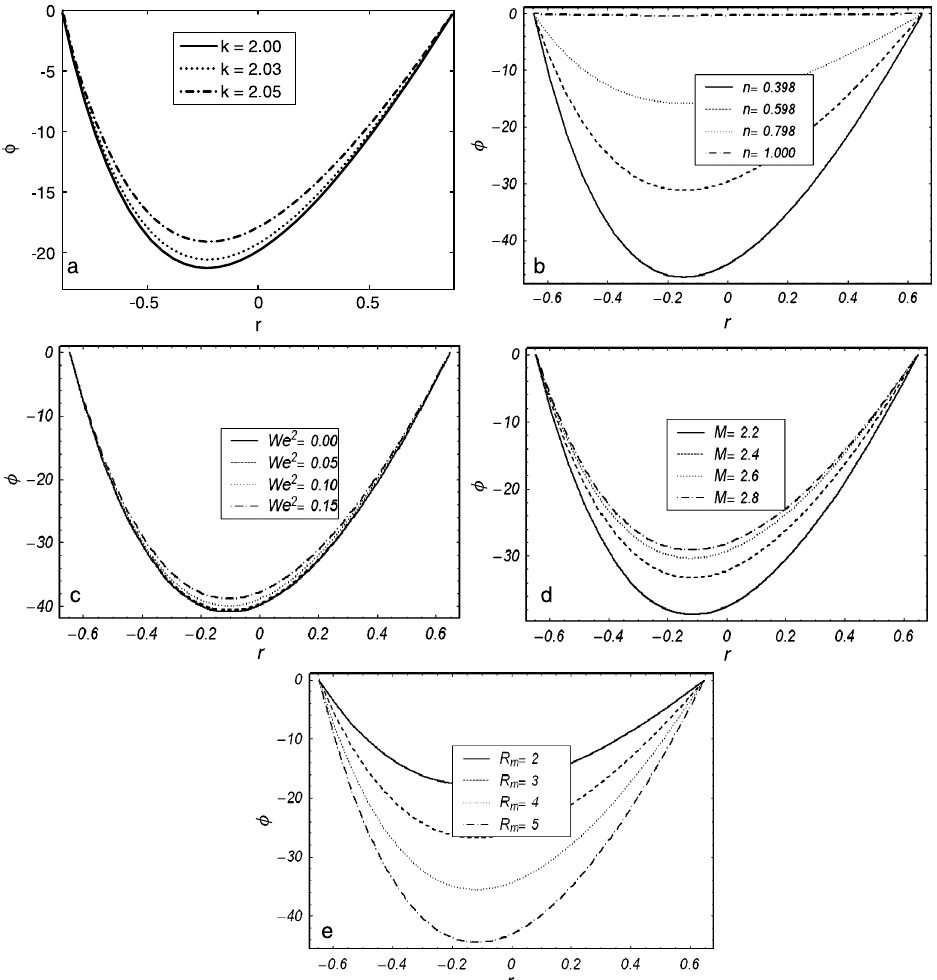
Fig. 4. (a) The magnetic force function φ versus r for n = 0 . 398, α = 0 . 2 ,θ = − 2 ,E = 1 ,x = 0 . 6 ,We = 0 . 02 ,R m = 4 and M = 2. (b) The magnetic force function φ versus r for k = 1 . 5, α = 0 . 6 ,θ = − 2 . 8 ,E = 1 ,x = 0 . 6 ,We = 0 . 02 ,R m = 2 and M = 1 . 9. (c) The magnetic force function φ versus r for k = 2 . 2, α = 0 . 6 ,θ = − 2 . 8 ,E = 1 ,x = 0 . 6 ,n = 0 . 398 ,R m = 4 and M = 2. (d) The magnetic force function φ versus r for k = 2 . 2, α = 0 . 6 ,θ = − 2 . 8 ,E = 1 ,x = 0 . 6 ,n = 0 . 398 ,R m = 4 and M = 2. (e)The magnetic force function φ versus r for k = 2, α = 0 . 6 ,θ = − 2 . 8 ,E = 1 ,x = 0 . 6 ,n = 0 . 398 ,We = 0 . 02 and M = 2 .